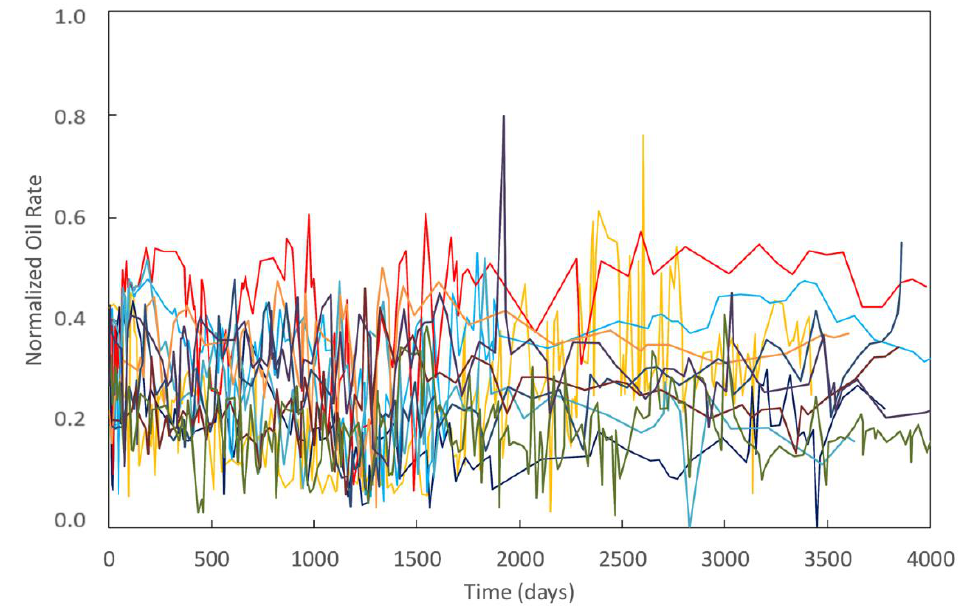
Figure 2. Normalized production oil rate data for multiple wells.